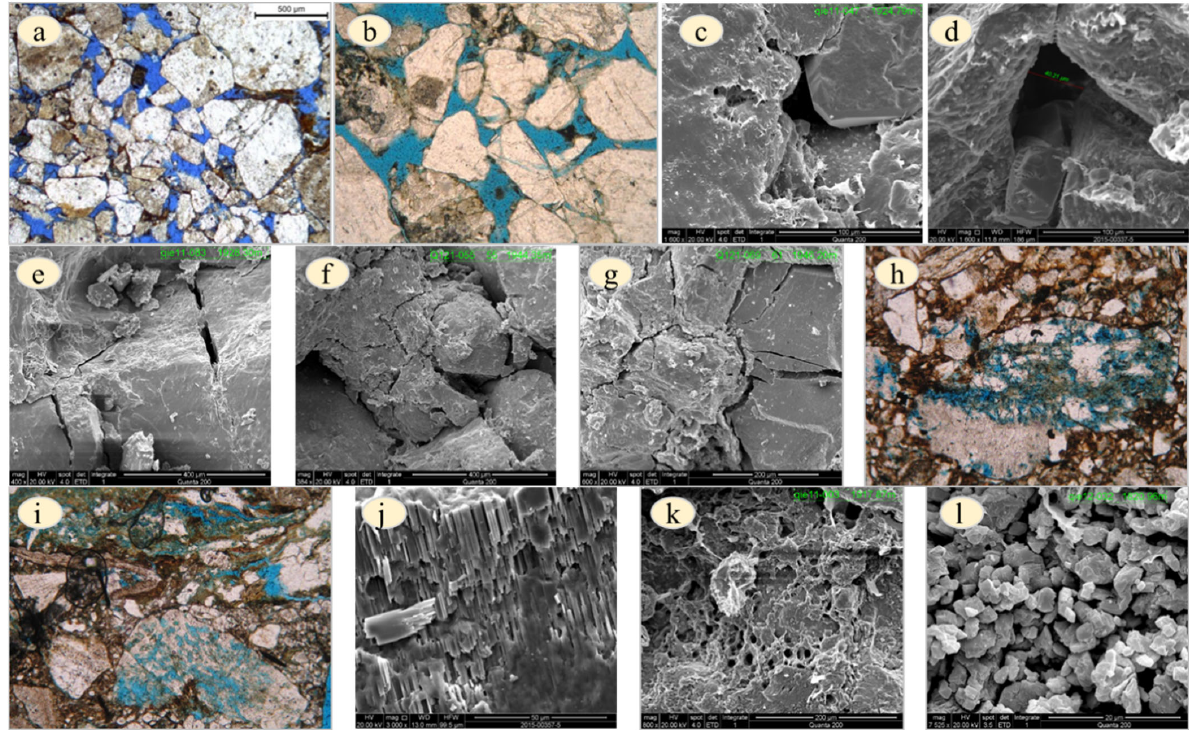
Figure 3. Characteristics of reservoir storage space in the Qie12 block: ( a ) Well Qie12 − 10 − 8, 1857.01 m, medium ‐ coarse ‐ grained feldspar lithic sandstone, primary intergranular pores; ( b ) Well Qie11, 1920.13 m, gravel ‐ bearing coarse sandstone, primary intergranular pores, ( ‐ ) × 25; ( c ) Well Qie11, 1924.79 m, sandy conglomerate, primary intergranular pores; ( d ) Well Qie12 − 10 − 8, 1850.82 m, gravel ‐ bearing coarse sandstone, primary intergranular pores; ( e ) Well Qie11, 1928.3 m, sandy conglomerate, cracked fracture; ( f ) Well Qie121, 1944.36 m, cracked fracture; ( g ) Well Qie121, 1946.2 m, cracked fracture; ( h ) Well Qie12, 1818.6 m, gravel ‐ bearing sandstone, detritus dissolution pores, ( ‐ ) × 25; ( i ) Well Qie12, 1820.5 m, pebbly sandstone, feldspar dissolution pores, ( ‐ ) × 25; ( j ) Well Q12 − 7 − 28, 1831.72 m, sandy conglomerate, feldspar dissolves along the joint; ( k ) Well Qie11, 1917.87 m, sandy conglomerate, argillaceous micropores; and ( l ) Well Qie12, 1820.96 m, argillaceous mi ‐